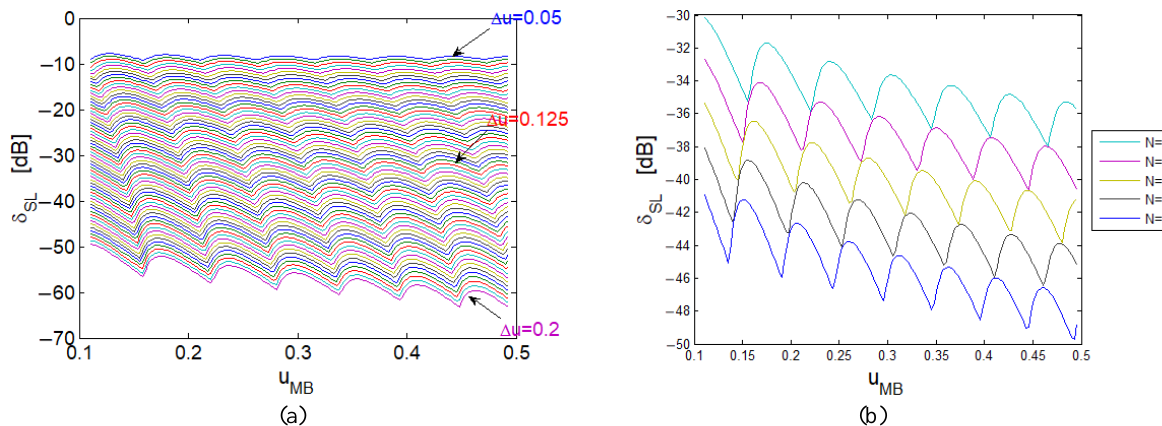
Figure 6. Maximum side lobe level 𝛿 𝑆𝐿 (in dB) as a function of 𝑢 𝑀𝐵 , obtained for 𝛿 𝑀𝐵 = 0.05 and ( a ) 𝑁 = 20 with Δ𝑢 = 0.05,0.125,0.2 , ( b ) Δ𝑢 = 0.15 with 𝑁 from 18 to 22 .